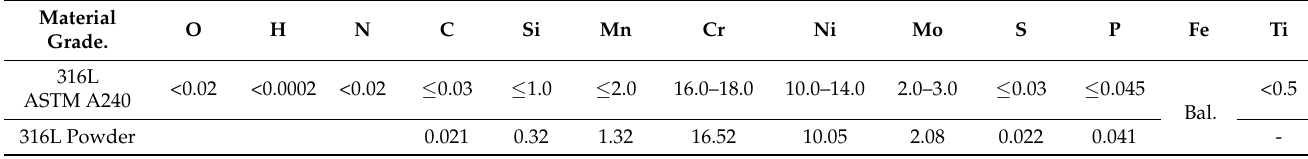
Table 1. The chemical composition of the